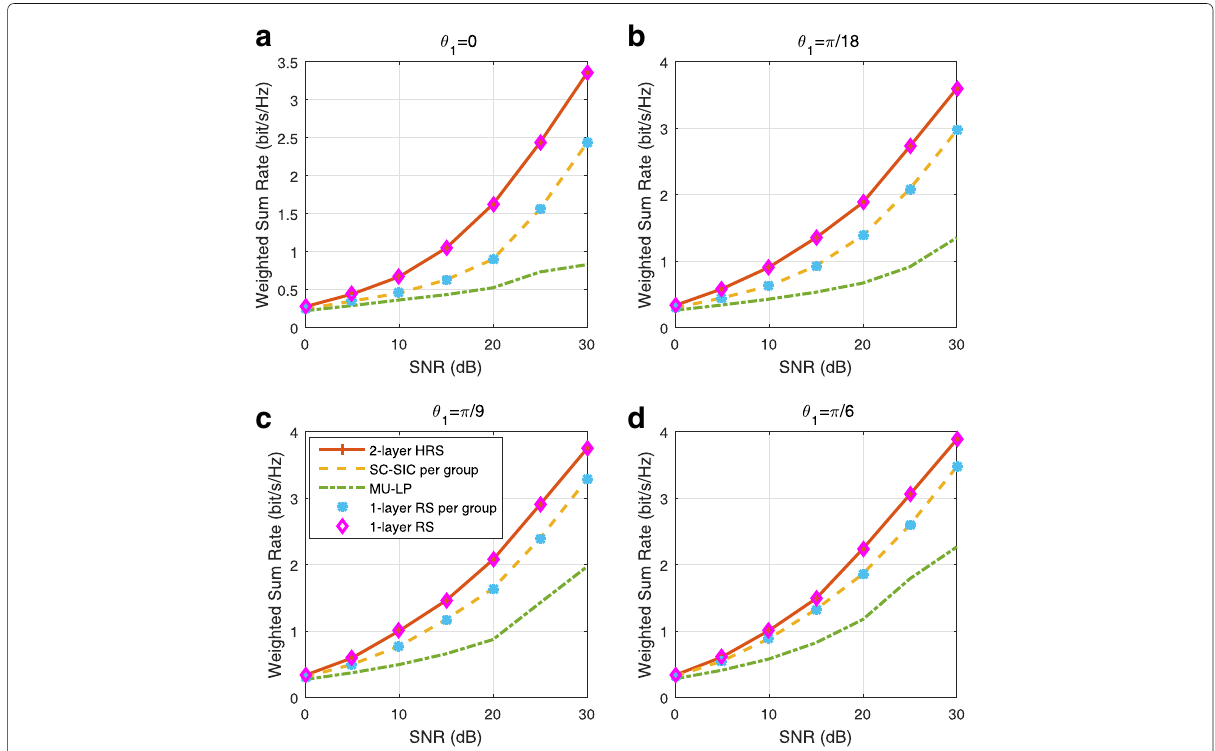
Fig. 18 Weighted sum rate versus SNR comparison of different strategies for overloaded four-user deployment with perfect CSIT, γ 1 = 0.3, = θ + π θ , r th = [0.03,0.1,0.2,0.3,0.4,0.4,0.4] bit/s/Hz. a θ 1 = 0. b θ 1 = π/ 18. c θ 1 = π/ 9. d θ 1 = π/ 2 1 9